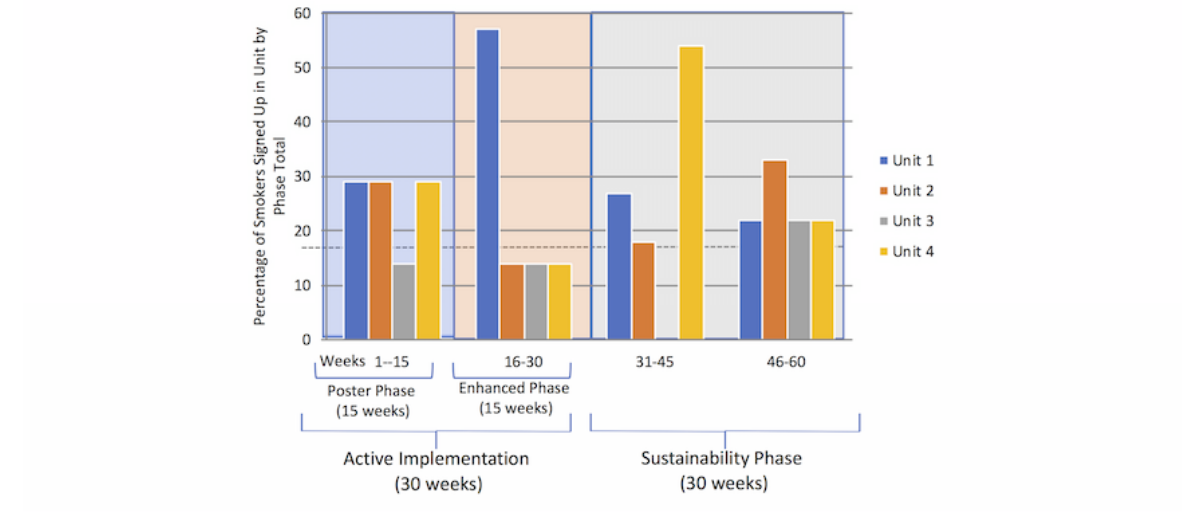
Figure 3. Reach of the Technology Inpatient Program for Smokers intervention by unit and phase. Analysis included only participants who reported location (N=41). Missing responses due to no response (N=57), smokers not on a hospital unit (N=3), and smokers who were unsure what unit they were on (N=2) are assumed to be at random. Mean new smokers signed up for all units over all phases is 2.6 smokers, represented by a dashed line.